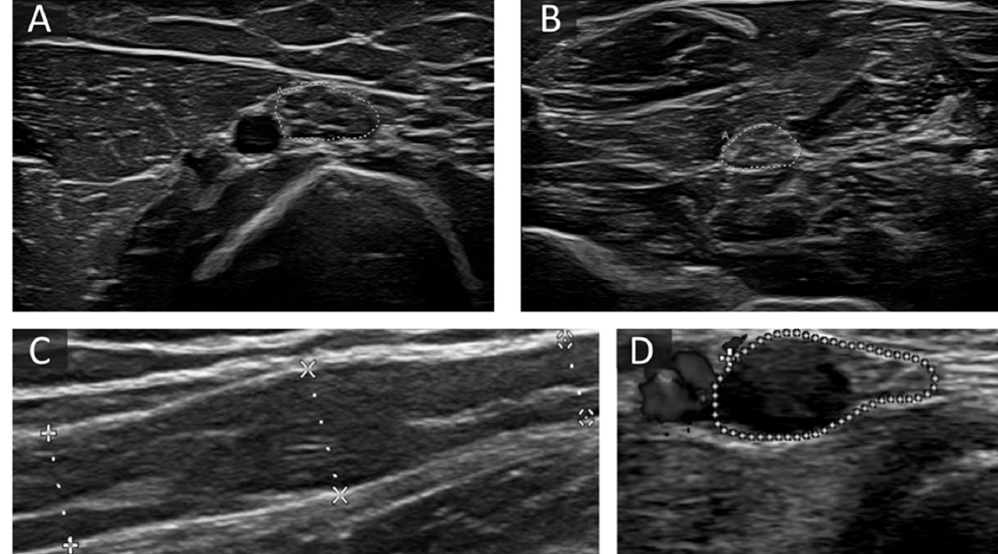
Figure 3. Examples of altered nerve morphology in immune-mediated neuropathies. ( A,B ) Cross-sectional view of the median nerve at the upper arm (30 mm²) ( A ) and forearm (17 mm²) ( B ) in a patient with chronic inflammatory demyelinating polyneuropathies (CIDP). CSA is predominantly enlarged at proximal sites, and fascicles are iso- and hyperechoic. ( C ) shows a long-axis view of a segmentally enlarged median nerve at the upper arm in a patient with Lewis-Sumner Syndrome (LSS). ( D ) The short-axis view shows an ulnar nerve at the forearm next to the ulnar artery with one very large fascicle with hypoechoic signal next to preserved fascicles in a patient with multifocal motor neuropathy (MMN). The area enclosed by the discontinuous points in picture A, B and D depict CSA, in picture C diameter of the described nerve section. “A” in pictures B and D means